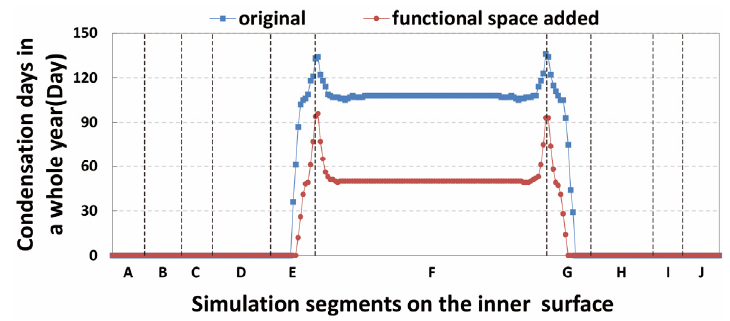
Figure 22. Condensation days on each segment.